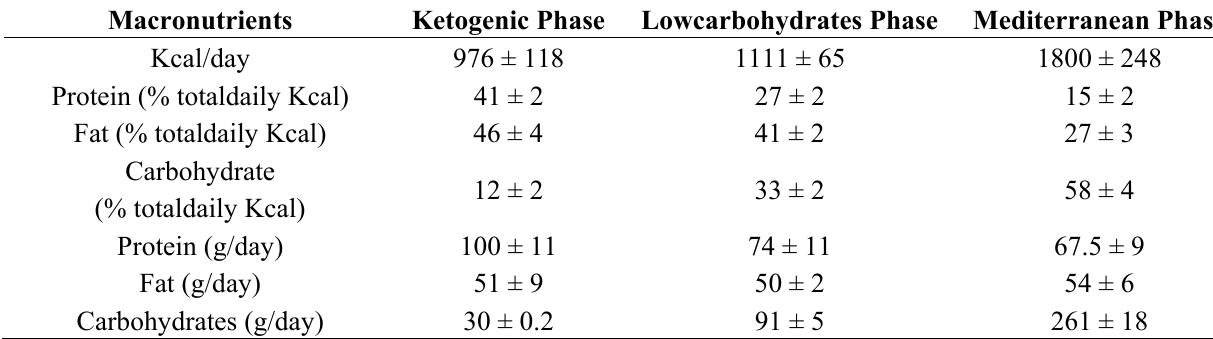
Table 1. Characteristics of diets (data are expressed as mean and